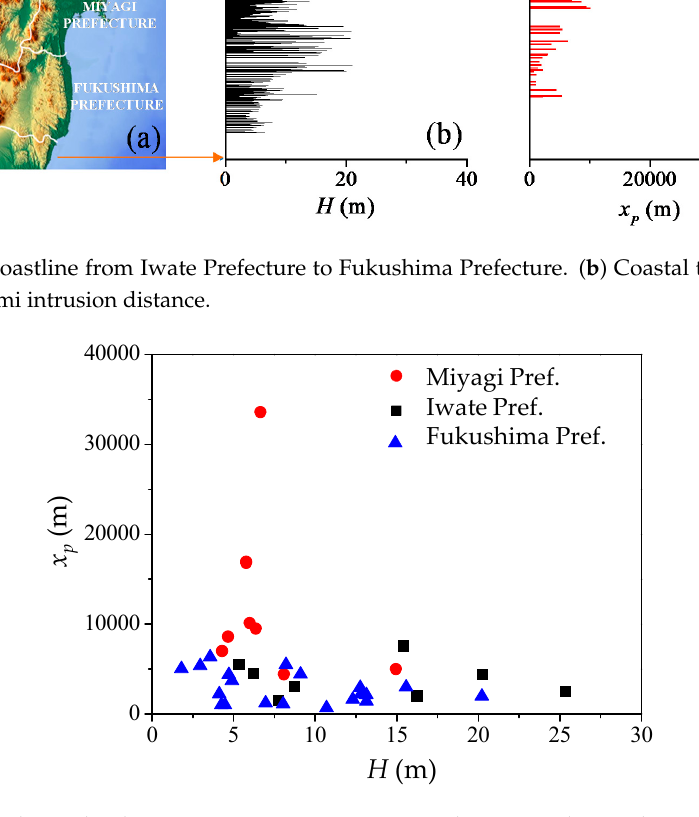
Figure 4. Relationship between river tsunami intrusion distance and coastal tsunami height.